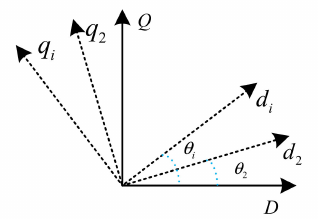
Figure 6. Schematic diagram of reference coordinate system transformation of multi-VSG system.